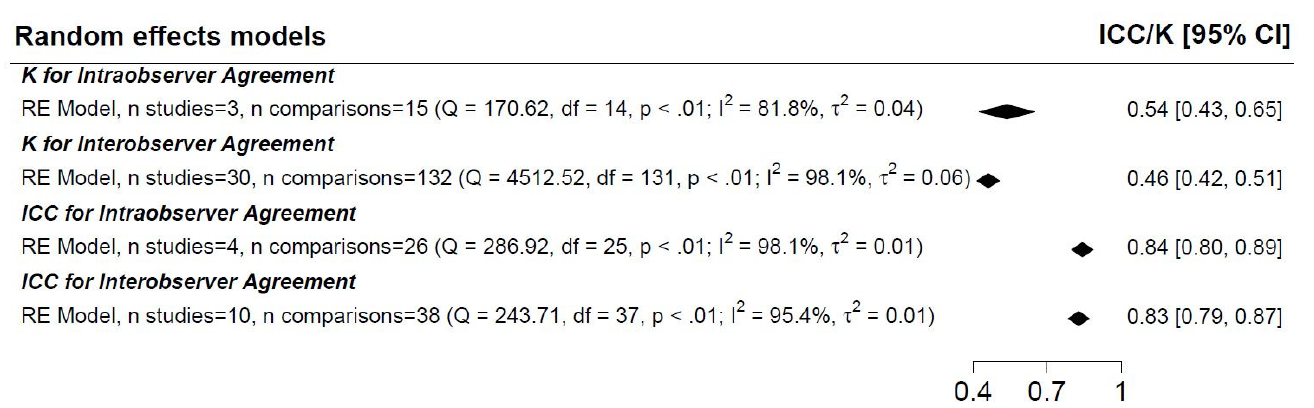
Figure 3. Circle bar chart visualizing the distribution of Kappa statistics and ICC values for every comparison.